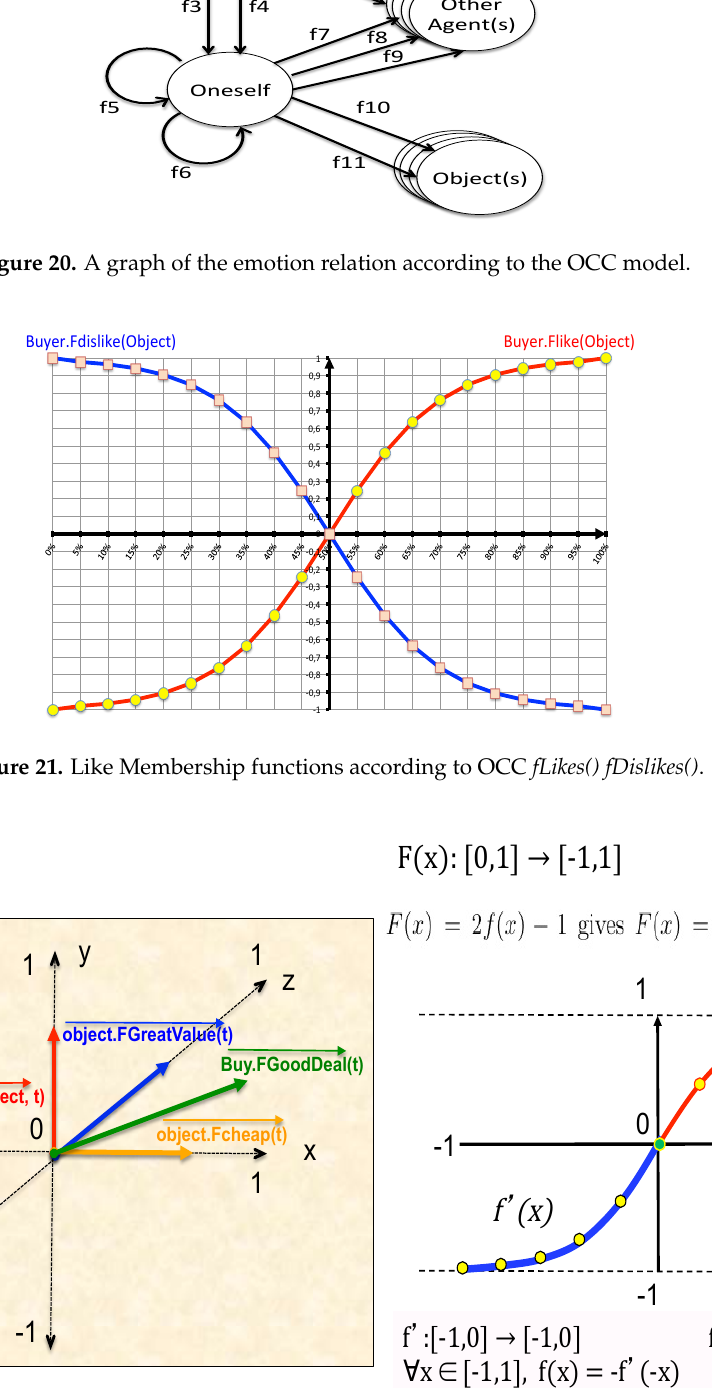
Figure 22. Time-fuzzy vector space (TFVS) of a good deal